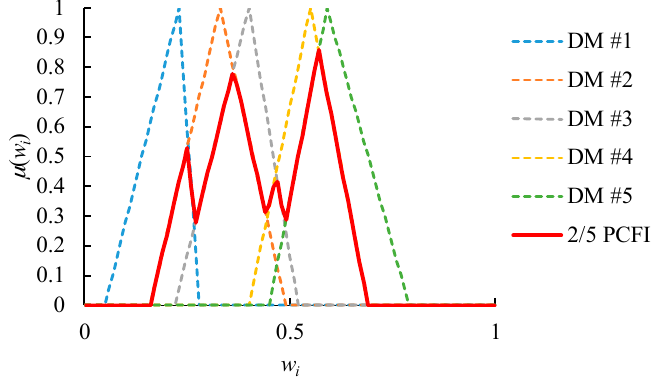
Figure 5. The 3/5 PCFI result.